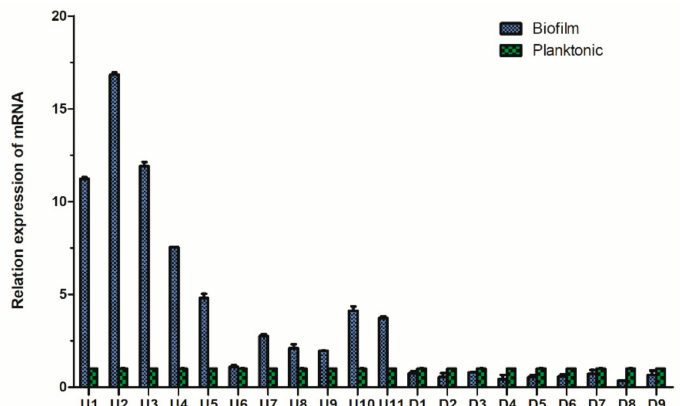
Figure 8. Comparison of the fluorescence quantitative PCR results of the di ff erential proteins of Aeromonas veronii TH0426 in planktonic and biofilm